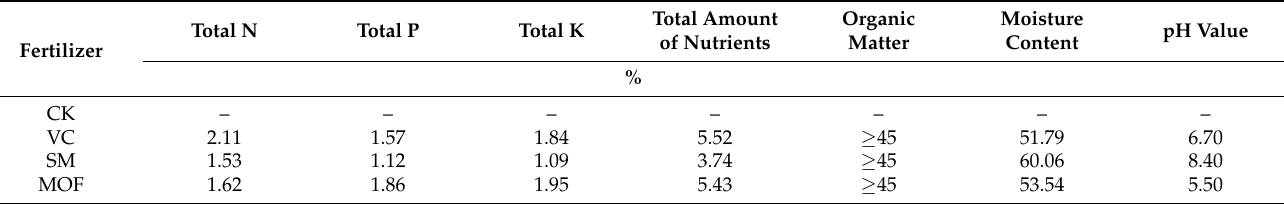
Table 1. Experimental fertilizer treatments properties.